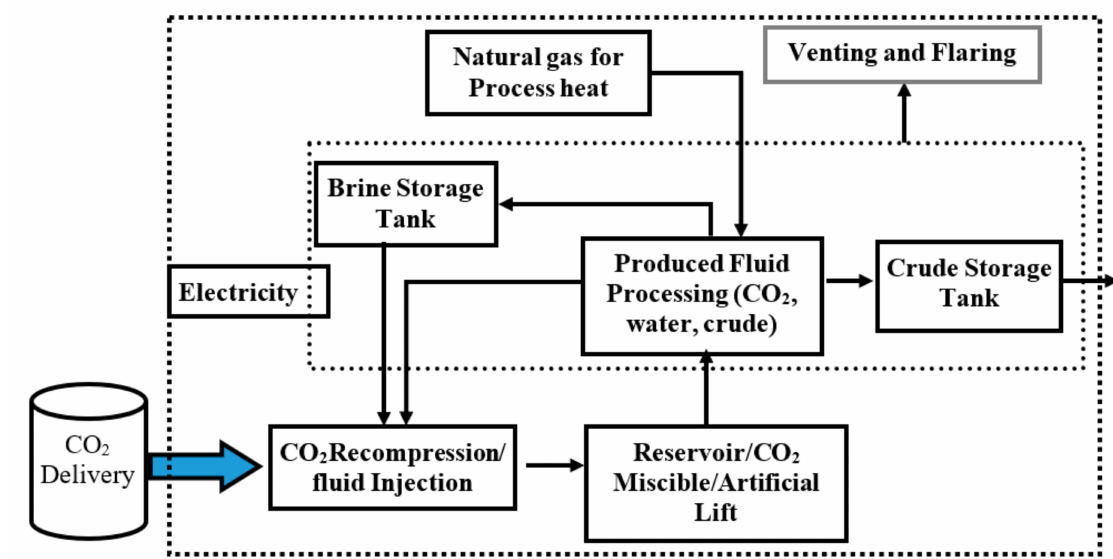
Figure 5. A simplified boundary/scope of Life Cycle Inventory for CO 2 - EOR at the